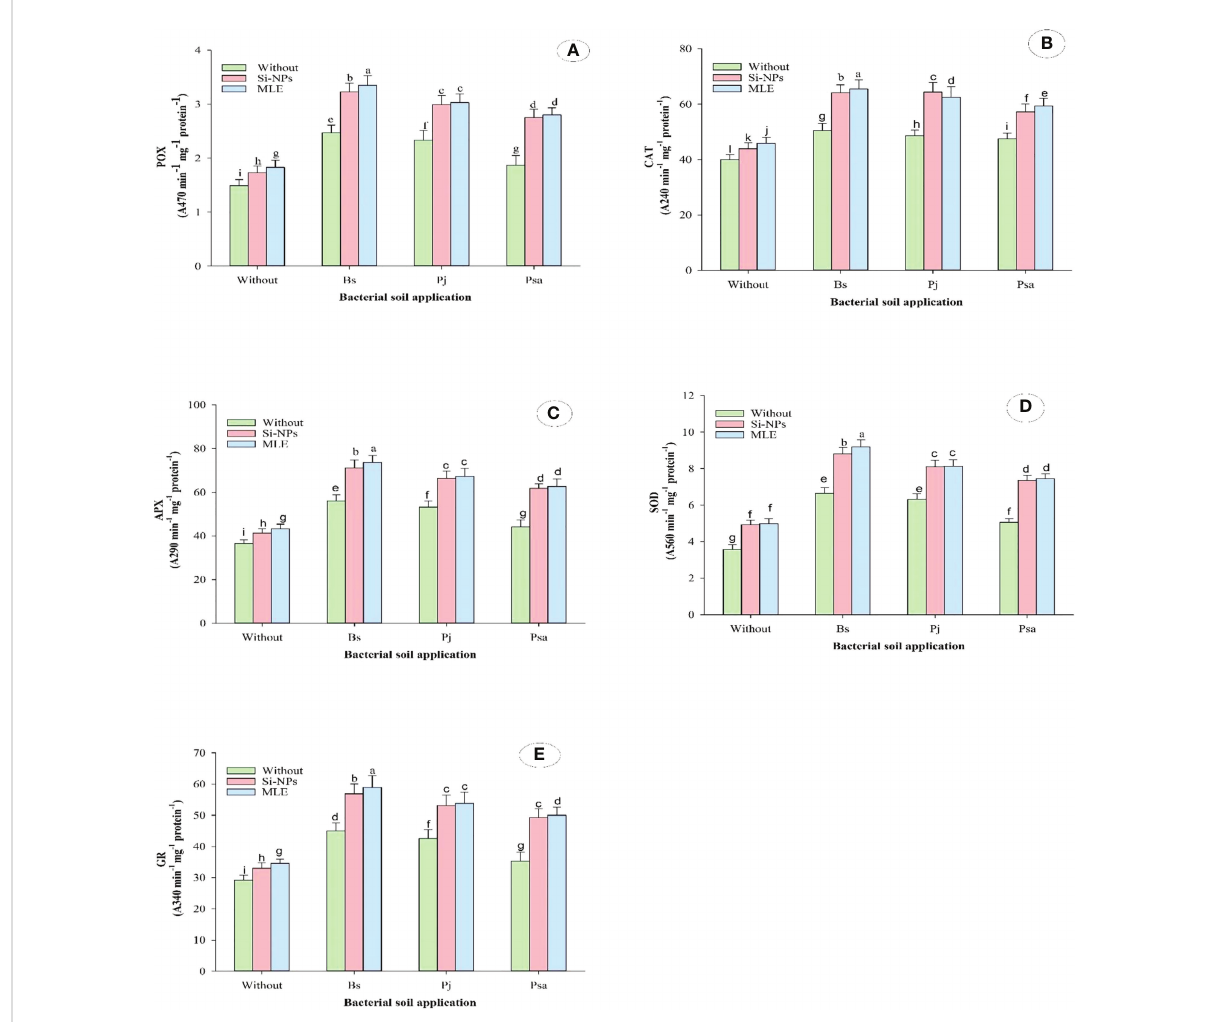
FIGURE 1 Changes in antioxidant enzymes [i.e., (A) peroxidase (POX), (B) catalase; CAT, (C) ascorbate peroxidase (APX), (D) superoxide dismutase (SOD), and (E) glutathione reductase (GR)] of heavy metal – stressed spinach plant in response to bioremediation of heavy metals bacterial applied as soil inoculation and/or foliar spray with MLE or Si-NPs.